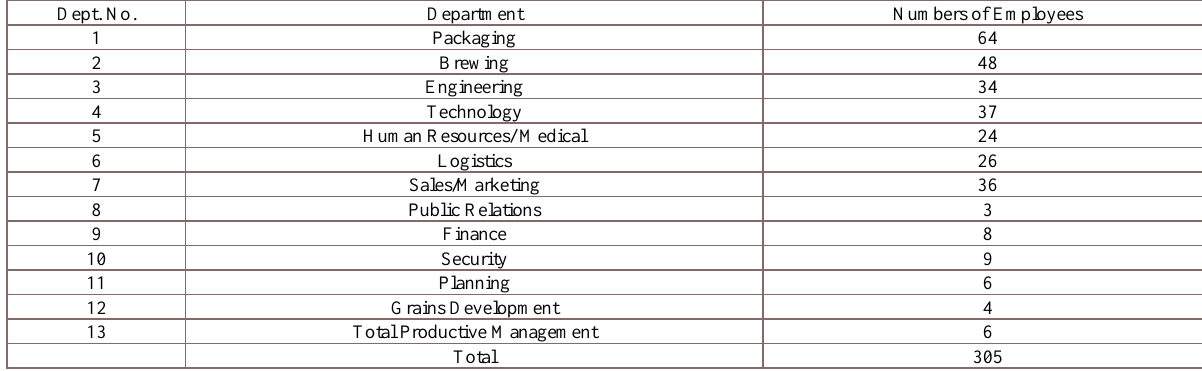
Table 1. Number of employees in NB Plc., Kaduna, as of